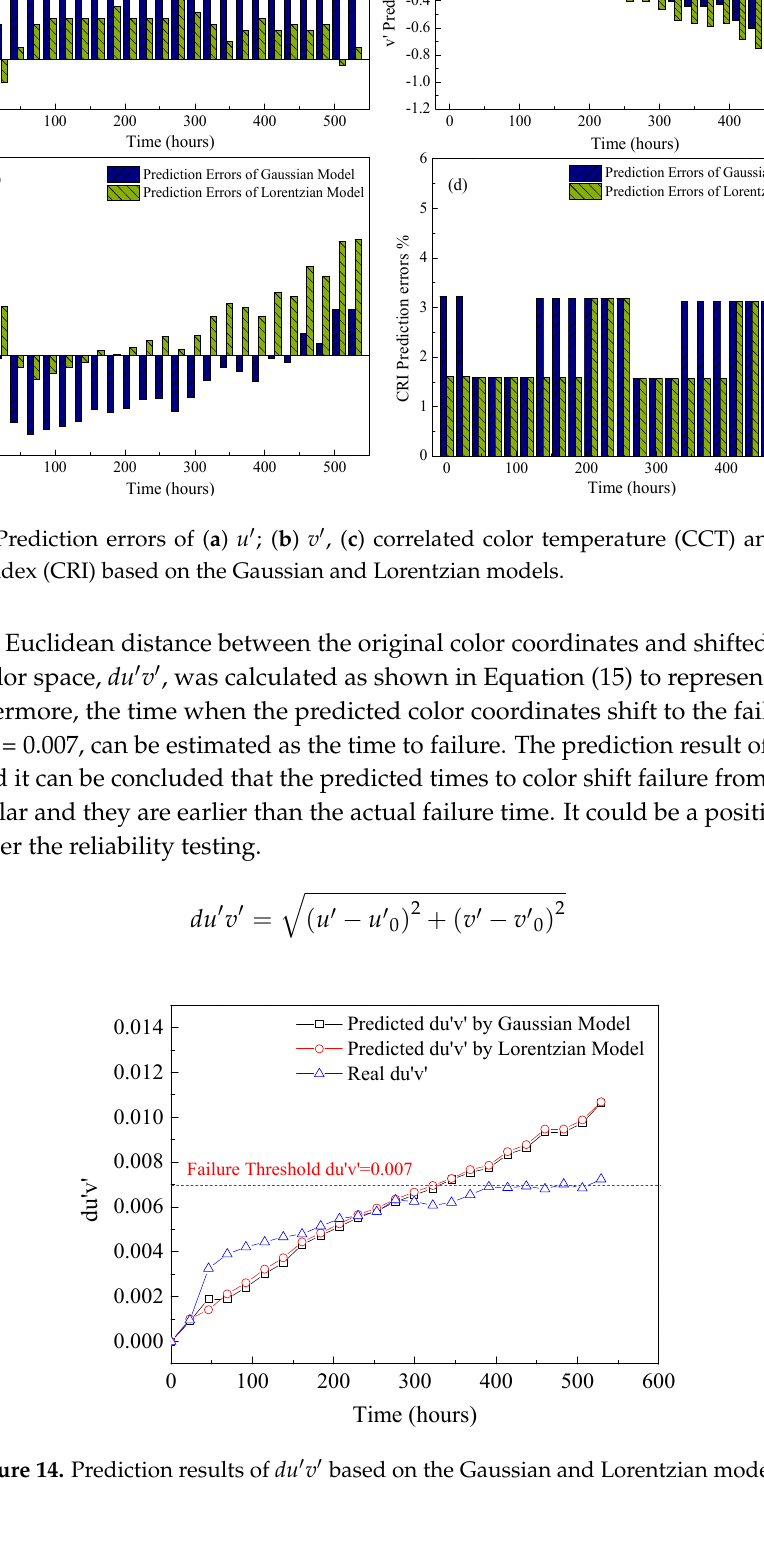
Figure 14. Prediction results of du ′ v ′ based on the Gaussian and Lorentzian models.